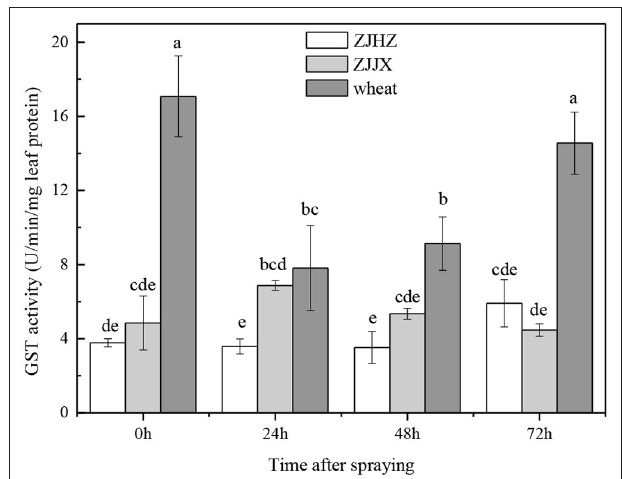
FIGURE 3 | GST activity in wheat and common roegneria populations ZJJX and ZJHZ at 0, 24, 48, and 72h after fenoxaprop- P -ethyl treated. Bars are mean ± SE ( n = 10). Bars designated by the same lowercase letter are not different according to Fisher protected LSD at P ≤ 0.05.